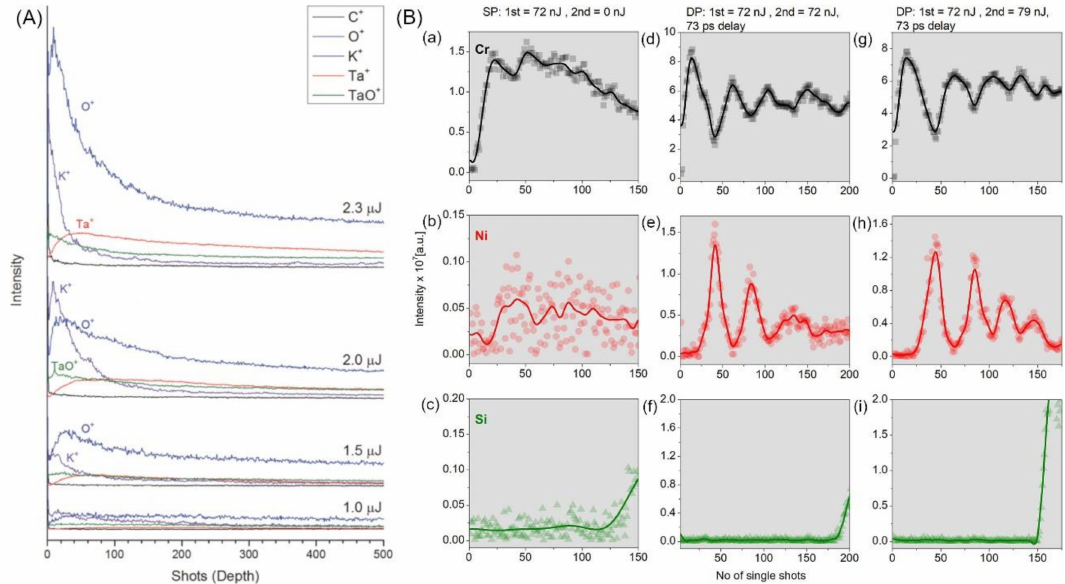
Figure 10. ( A ) Ion signal vs. laser shot number at various pulse energies. The data were obtained by ablating a ~330 nm Ta 2 O 5 film deposited on Ta foil [19]. ( B ) Comparison of a single pulse (SP) ( a – c ), double pulse (DP) with both pulses at the same energy (72 nJ) and~73 ps pulse delay ( d – f ), and DP with the first pulse at 72 nJ, the second pulse at 79 nJ, and ~73 ps pulse delay ( g – i ). Top, middle and bottom panels describe the recorded depth profiles of Cr, Ni and Si, respectively [82]. A clear improvement in the depth profiling resolution is seen between SP and DP operation. Reprinted with permission